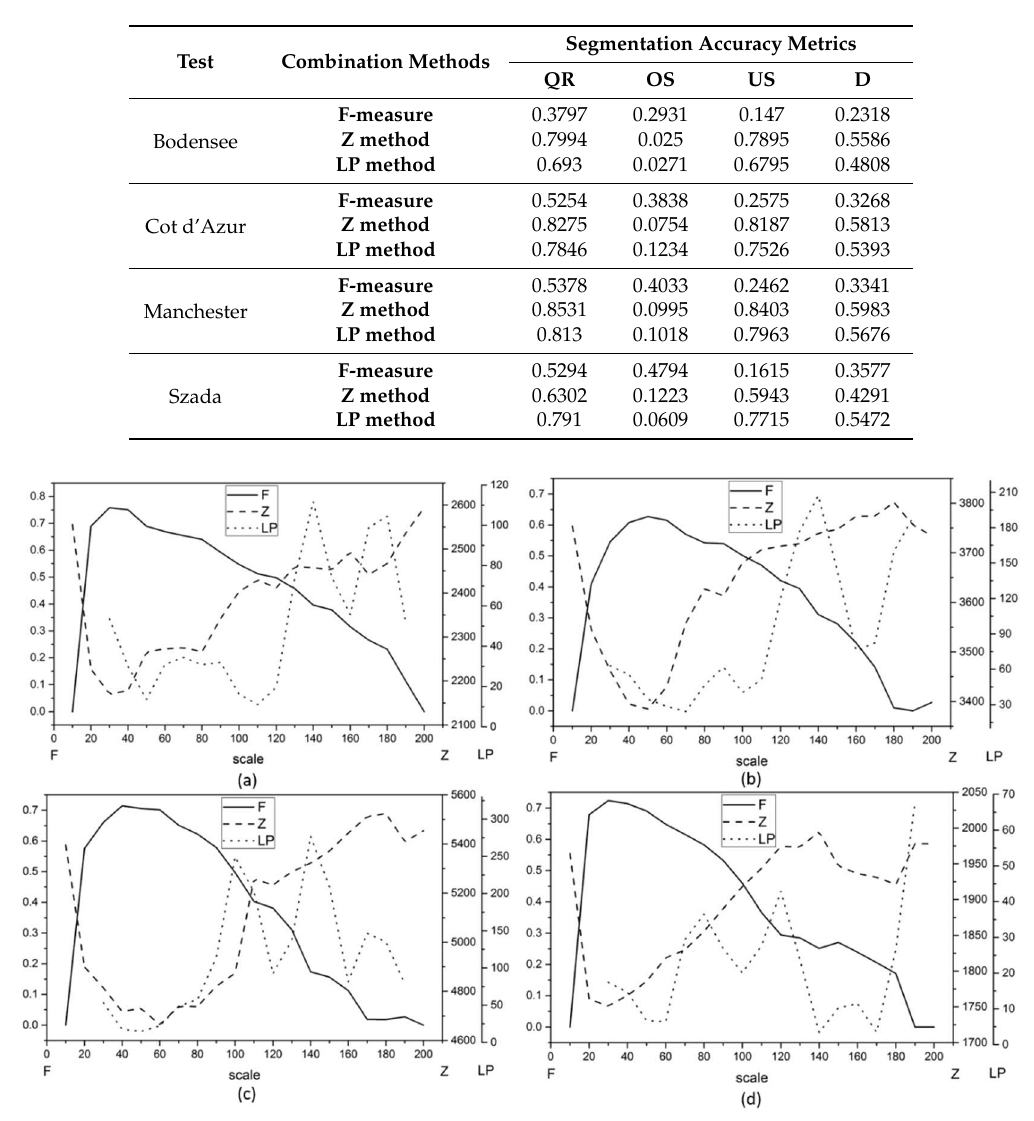
Figure 12. The UE results of the segmentations produced by the MRS method with different combination methods, using the SZTAKI-INRIA building detection dataset: ( a ) Bodensee, ( b ) Cot d’Azur, ( c ) Manchester, and ( d )